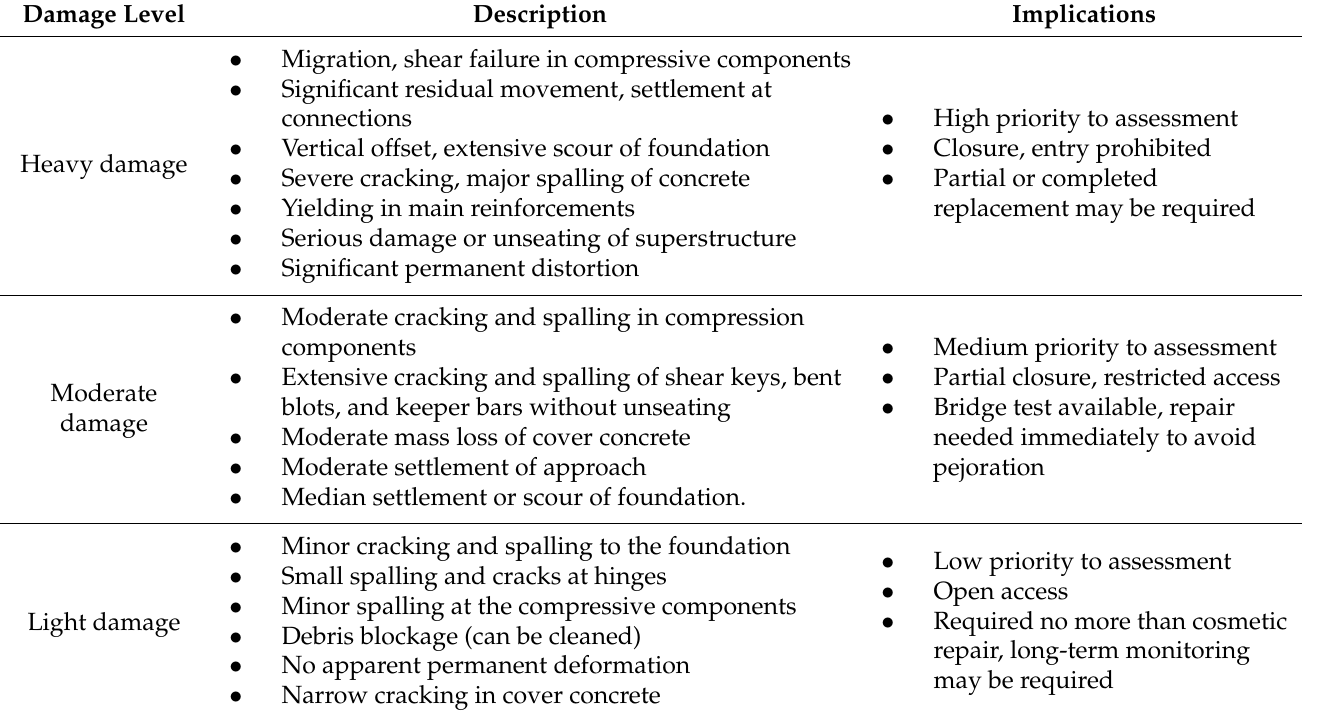
Table 3. Summarized damage level of